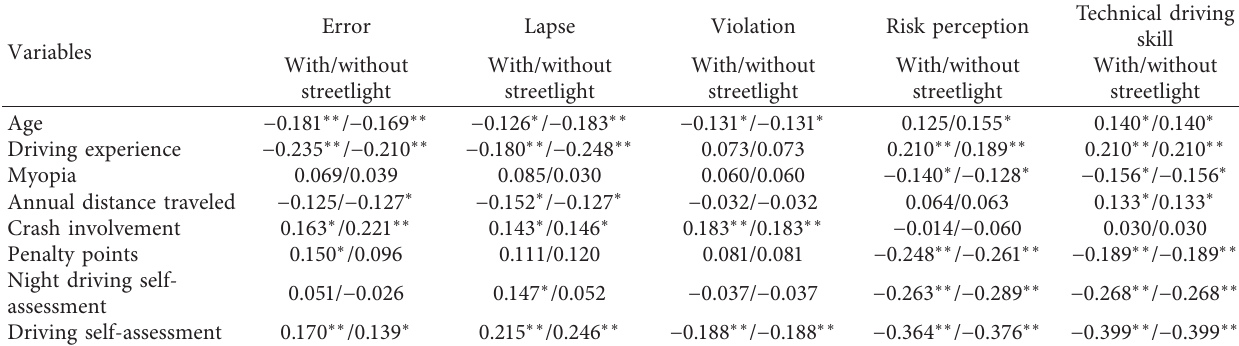
Table 8: Correlations between driver characteristics and the DBQ and DSI